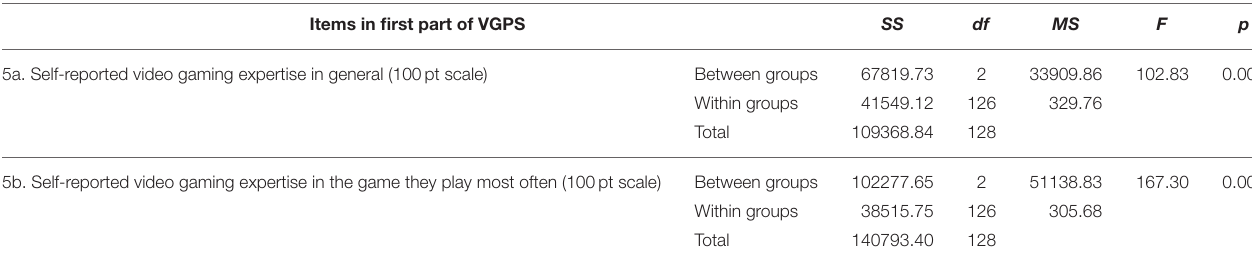
TABLE 5 | Comparison of self-reported video gaming expertise by within and between three expertise